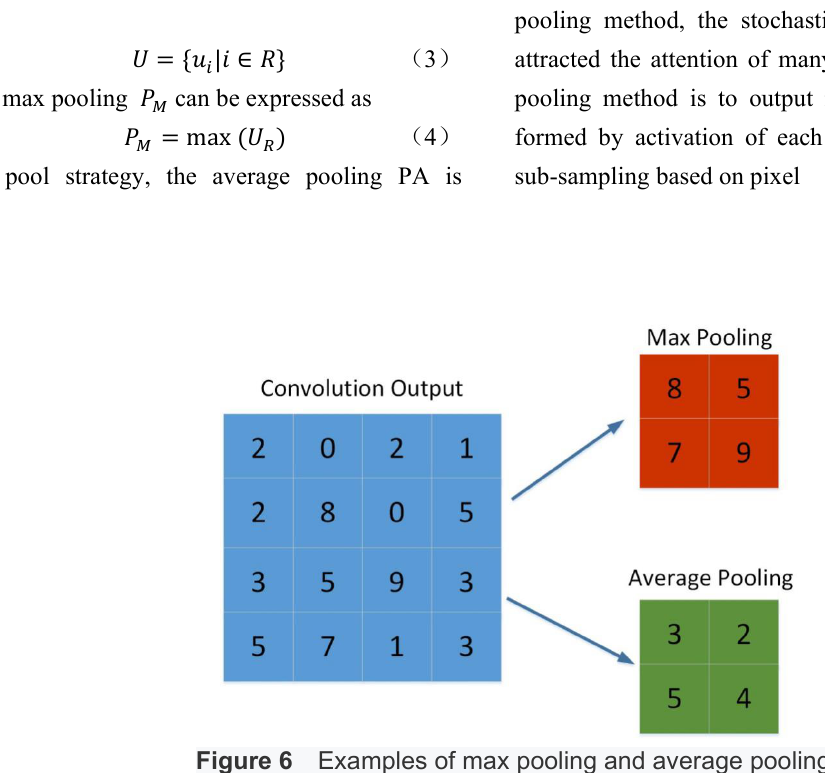
Examples of max pooling and average